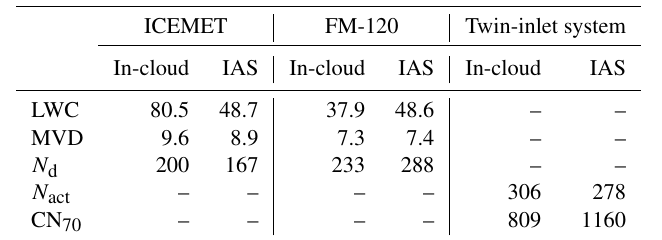
Figure 6. Ratios of cloud microphysical properties (FM-120 vs. ICEMET) within different wind directions calculated using FM-120 size bins of 2–50µm (a, c, e) and 5–50µm ( b, d, f ). Ratios of 1 : 1 are plotted in dashed lines. The wind sector (east) deviating from the sampling direction by less than 30 ◦ (isoaxial sampling) is limited by blue lines. Table 1. Summary of intercomparison for the total data set (In-cloud) and for isoaxial sampling (In-cloud IAS, θ ± 30 ◦ ): mean values of LWC (mgm − 3 ), MVD (µm), and N d (cm − 3 ) for ICEMET and FM-120. For the twin-inlet system, the number of N act (cm − 3 ) and CN 70 (cm − 3 ) are